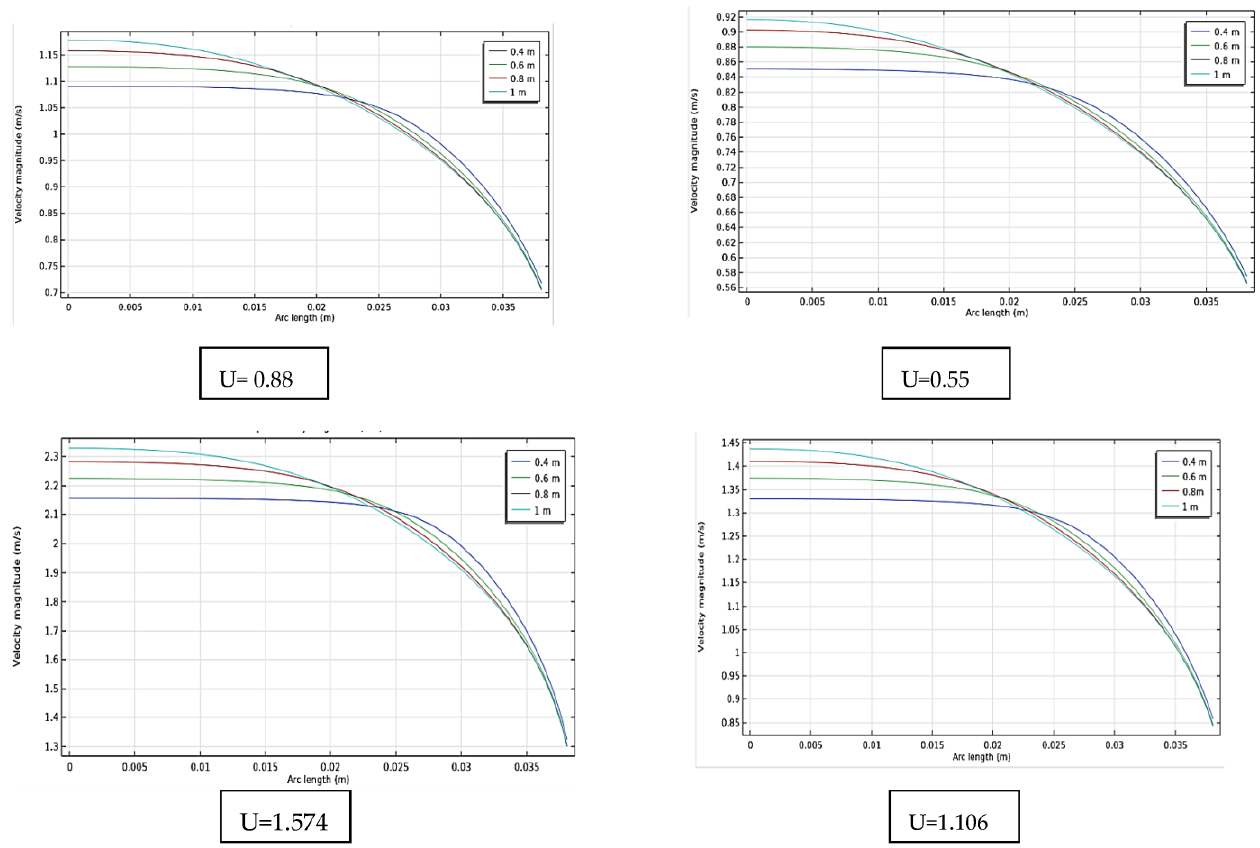
Figure 10. Velocity variation along the 1-m-long pipeline with 950 ppm XGs.